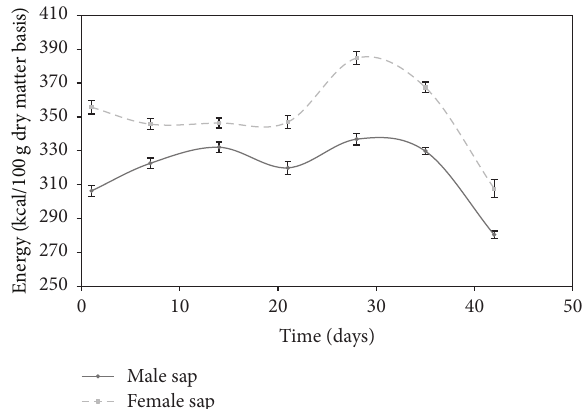
Figure 4: Variation of energy contribution of male and female date palm sap according to the collection